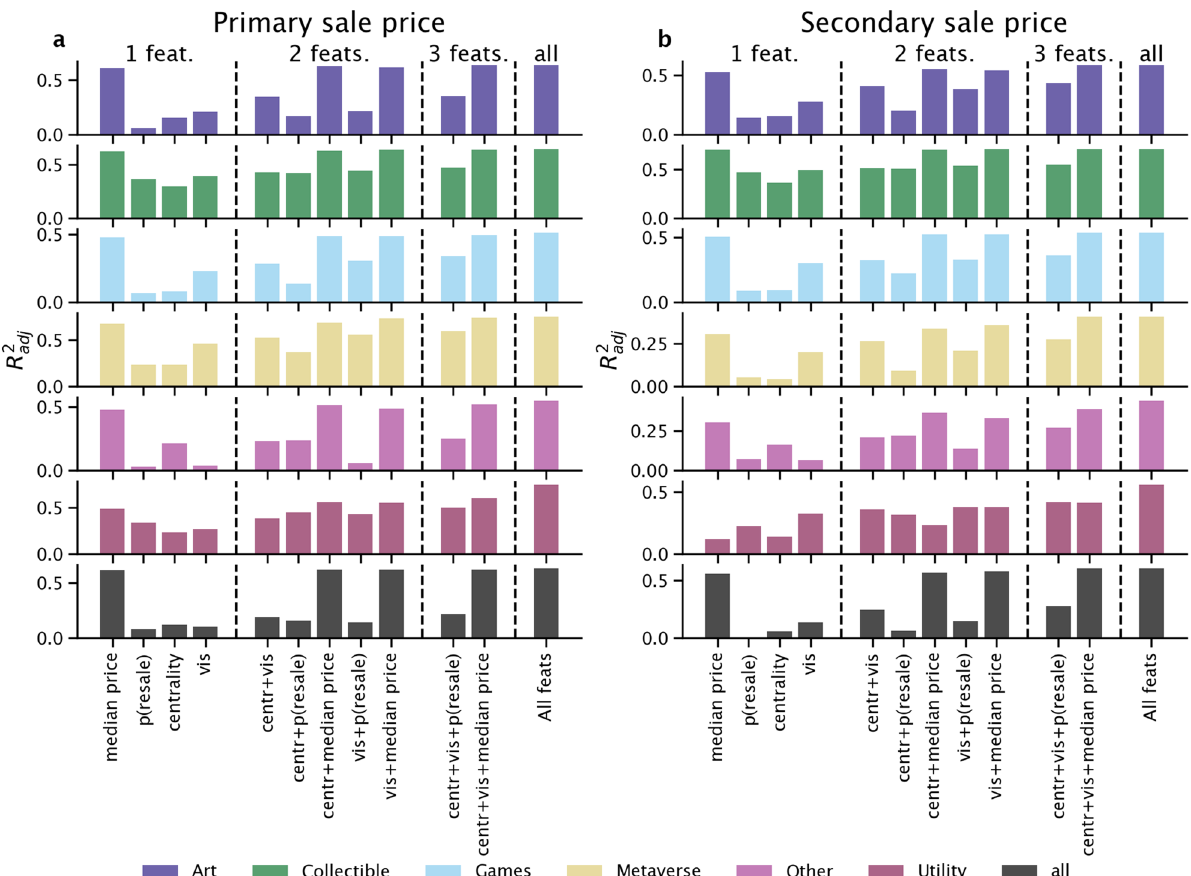
Figure 7. Regression results. R 2 adj of a linear regression fit to predict the primary sale price ( a ) and the secondary price sale 1 month after the primary sale ( b ) from different sets of features. Results are broken down by NFT categories. The abbreviation “feat(s).” stands for